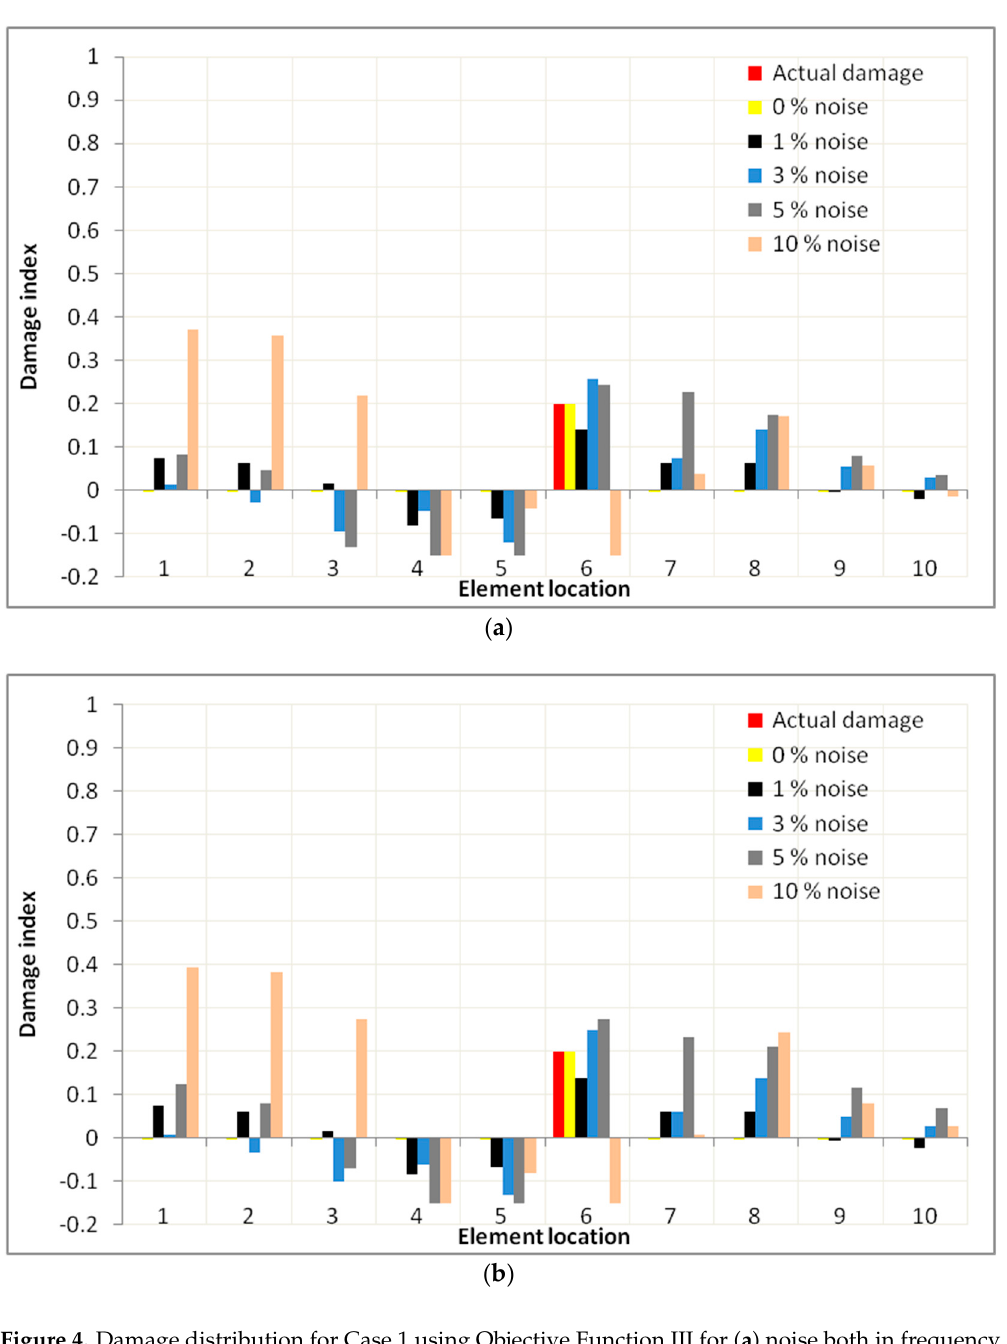
Figure 4. Damage distribution for Case 1 using Objective Function III for ( a ) noise both in frequency and mode shapes and ( b ) noise in mode shapes only.